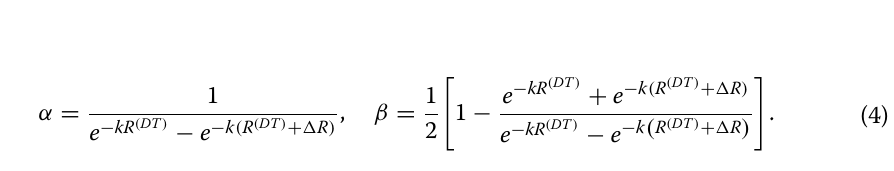
Fig. 5 Congestion radius pattern for the setup introduced in Sec. 5, with N = 3000 , L = 20 , R ( DT ) = 5 , and (cid:31) = 10 . Hybrid region is generated by overlapping a fraction π = 0.5 of DT edges sampled from the distribution in Eq. (2), with k = 0.1 . In the left panel, the blue histogram describes the final distribution of these edges. The right panel reports the congestion radius R c as a function of the parch radius R p . The black and purple dashed line report the result related to π = 1 and π = 0.05 respectively, where all the edges and approximately no one have been added, and match the situation described in Sec. 4. The dotted line refers to the edge distribution shown in the right panel, where circles are located at the statistical mode over an ensemble of 100 realizations. In this case transition exhibits a smooth, rather than abrupt, profile as a consequence of the non‑tight discontinuity in the edge